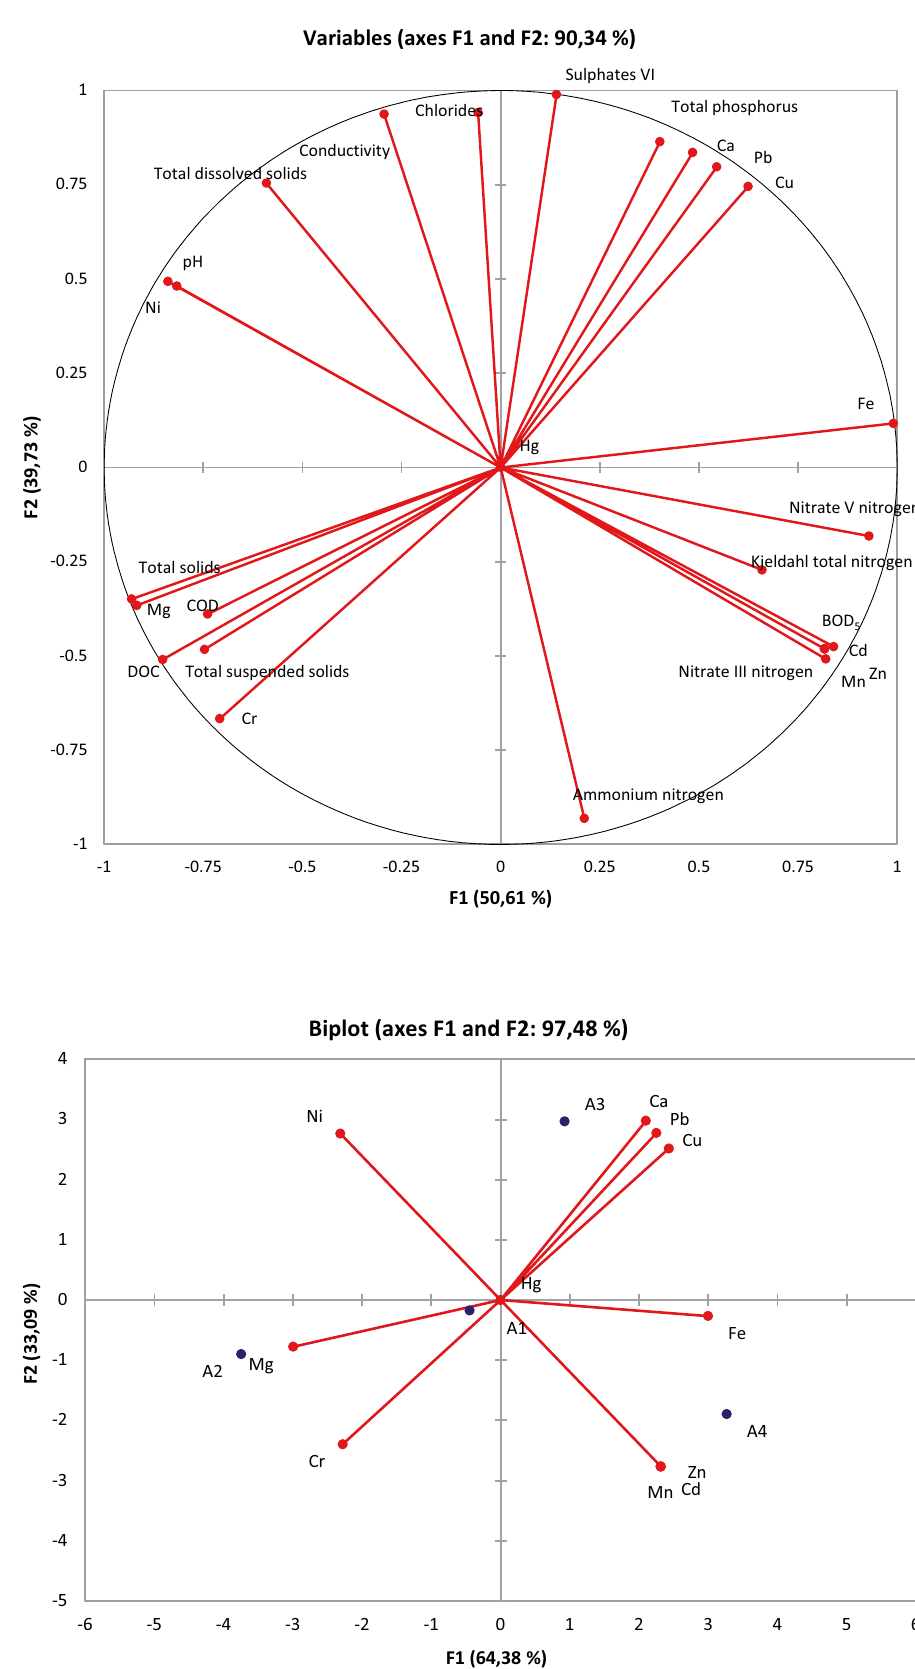
Fig. 9 Principal components analysis—projection of vari‑ ables set in 2D factor loading space